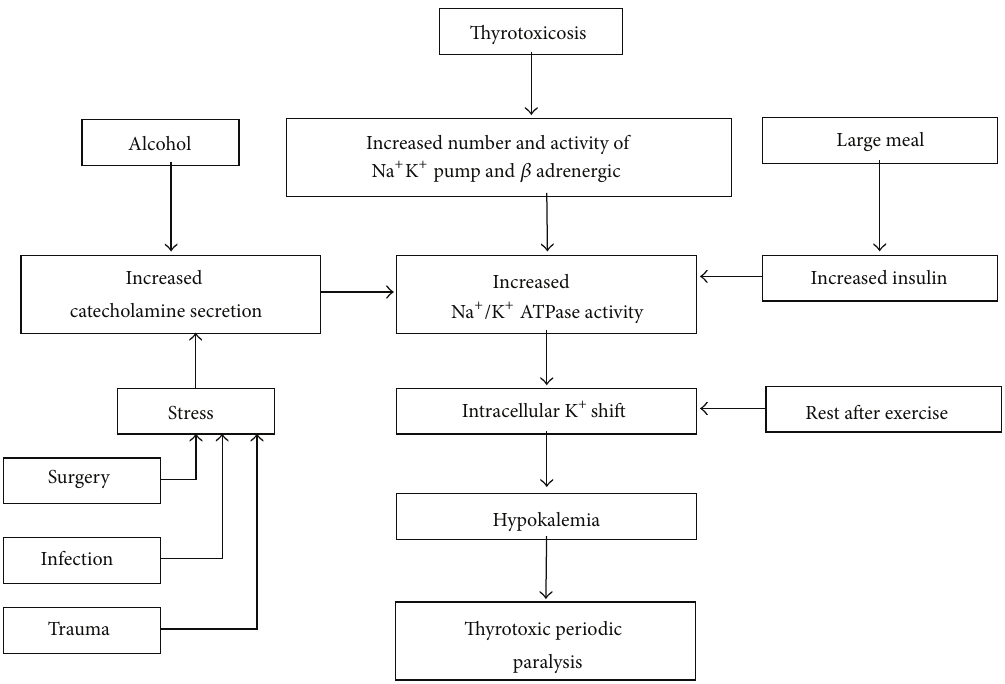
Figure 1: Precipitants of periodic